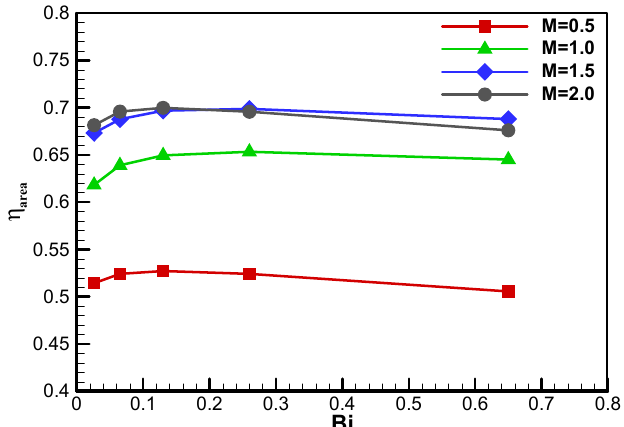
Figure 15. Influence of Biot number on area-averaged overall cooling effectiveness at M = 0.5–2.0.